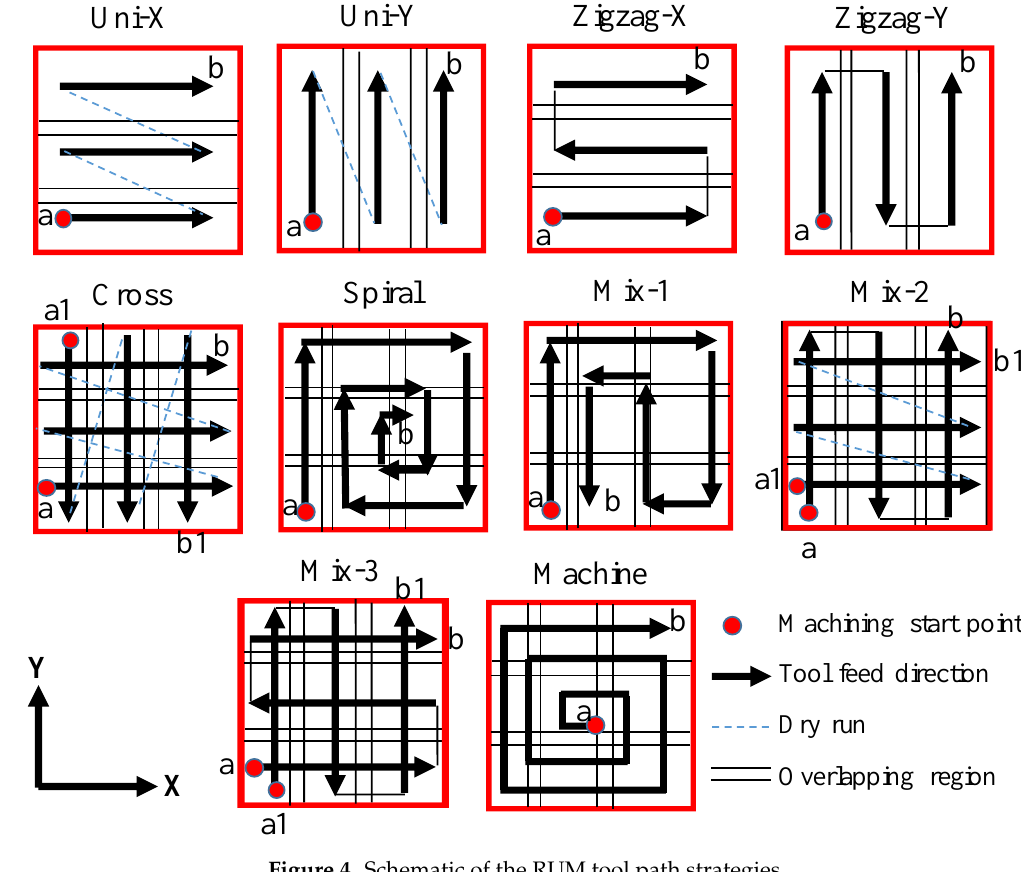
Figure 4. Schematic of the RUM tool path strategies. Table 4. Machining conditions adopted in this study.